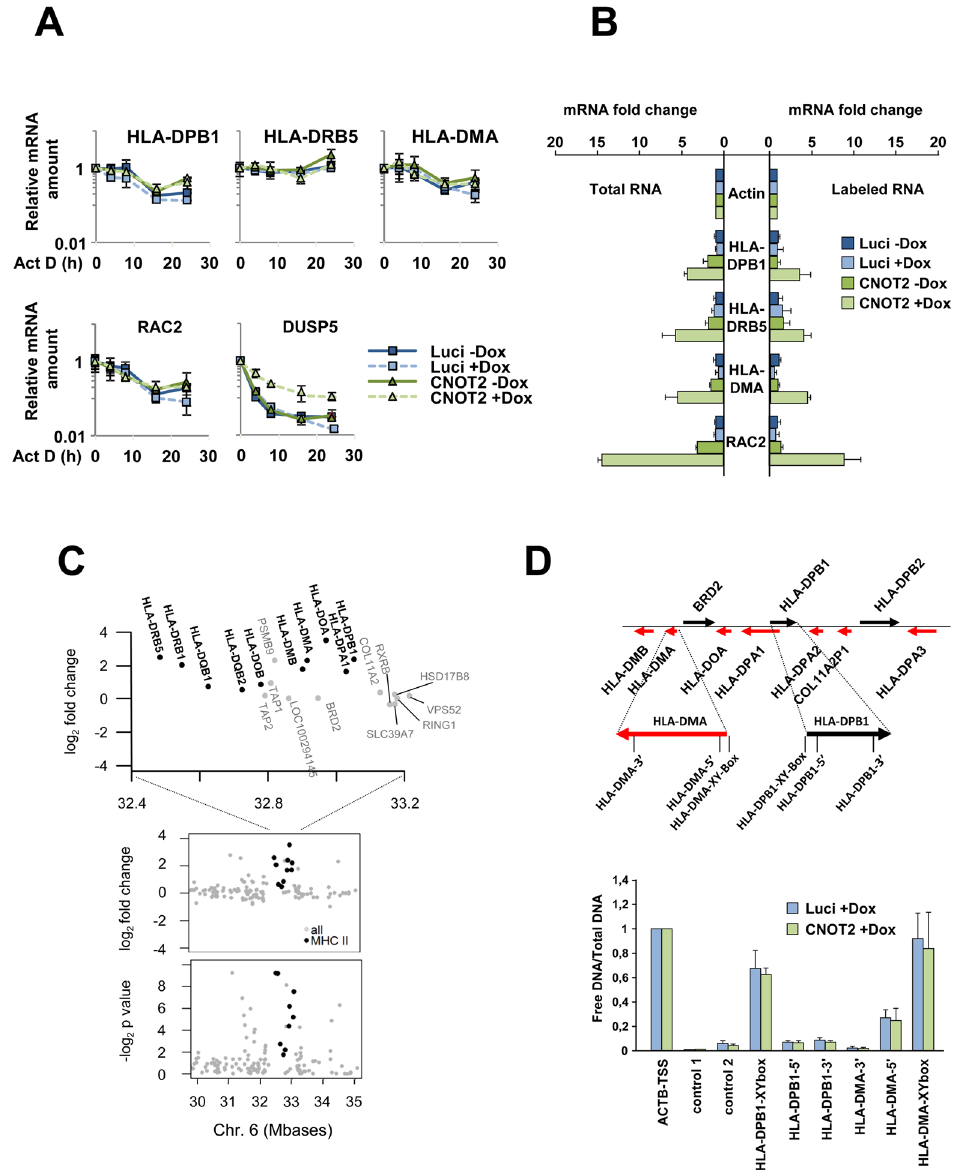
Figure 6. Mechanisms of CNOT2-dependent repression of MHC II transcription. ( A ) HEK-293T pIND Luci or pIND CNOT2 cells were incubated for 4 days in the presence of Dox to downregulate CNOT2. Subsequently the cells were treated with 1 μ g/ml of Actinomycin D for the indicated times to block de novo transcription and relative mRNA levels of CNOT2 target genes were quantified by RT-qPCR and normalized to the Actin levels. To facilitate comparison, all mRNA levels in the controls not treated with Actinomycin D were set as 1. The error bars represent the standard deviation of three biological replicates. ( B ) HEK-293T pIND Luci or pIND CNOT2 cells were treated for 4 days with Dox to downregulate CNOT2 as shown. Subsequently 4-thiouridine was added for 20 min and RNA was isolated by Trizol extraction. One tenth of the RNA was used for cDNA synthesis and RT-qPCR, while the remaining RNA was biotinylated in vitro and purified via Streptavidin-coupled beads as specified in Materials and Methods. The purified RNA represents the de novo transcribed fraction which was further analyzed by cDNA synthesis and RT-qPCR. The results show changes in gene expression, error bars represent the standard deviation of three biological replicates. ( C ) The CNOT2- dependent changes at the MHC II locus on chromosome 6 are shown with p-value of the differential expression (lower panel) and as fold changes (upper panels). The position of the loci on chromosome 6 is indicated, the MHC class II genes are highlighted in bold. ( D ) Quantification of free DNA versus chromatinized DNA as determined by FAIRE in the depicted regions of the MHC class II locus. The upper part shows a schematic representation of the locus, the lower part displays the results with error bars representing standard deviations from two biological replicates. The transcription start site for the beta Actin gene (ACTB-TSS) was used as a positive